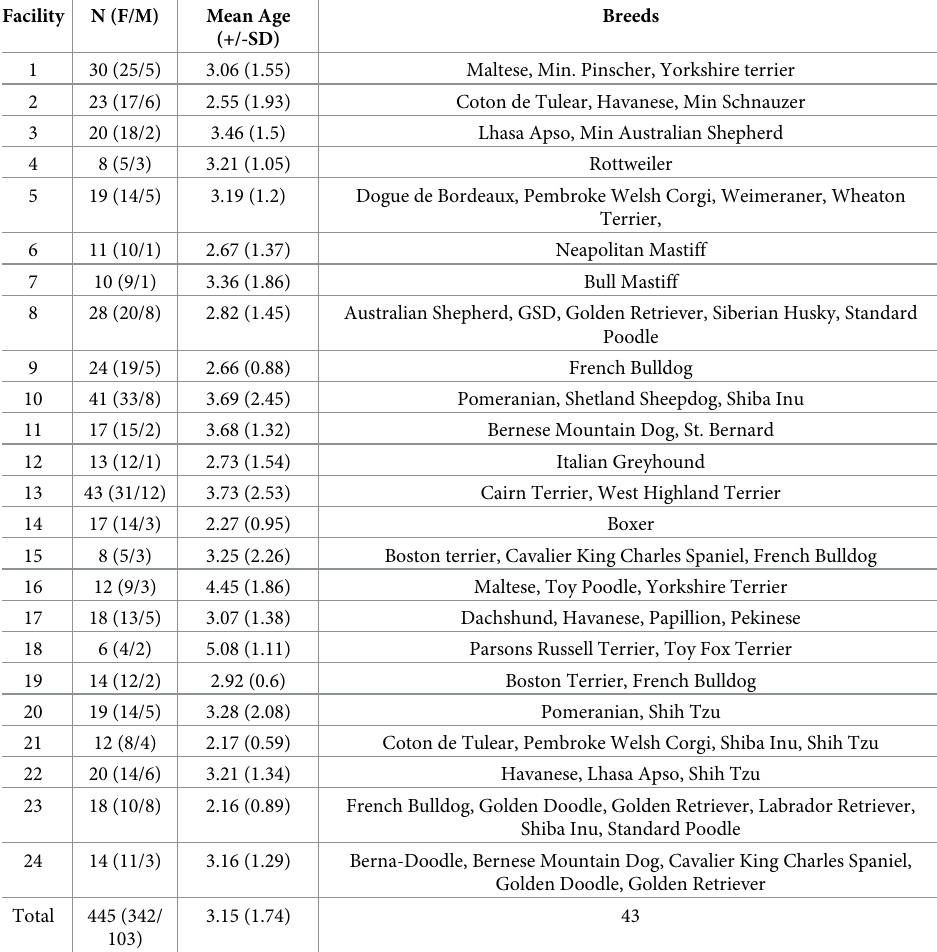
Table 1. Demographic information of the study population by facility. N = number of dogs examined, F = females, M = males; mean age in years, SD = standard deviation.